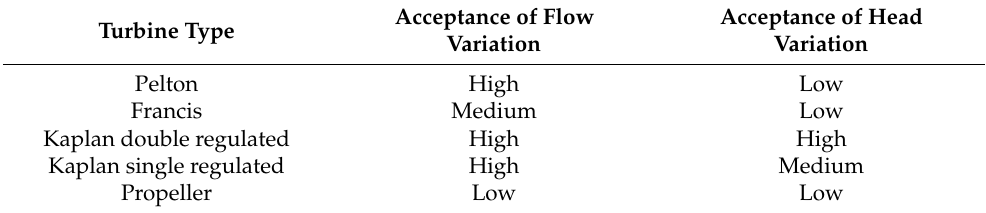
Table 1. Flow and head variation acceptance [41].